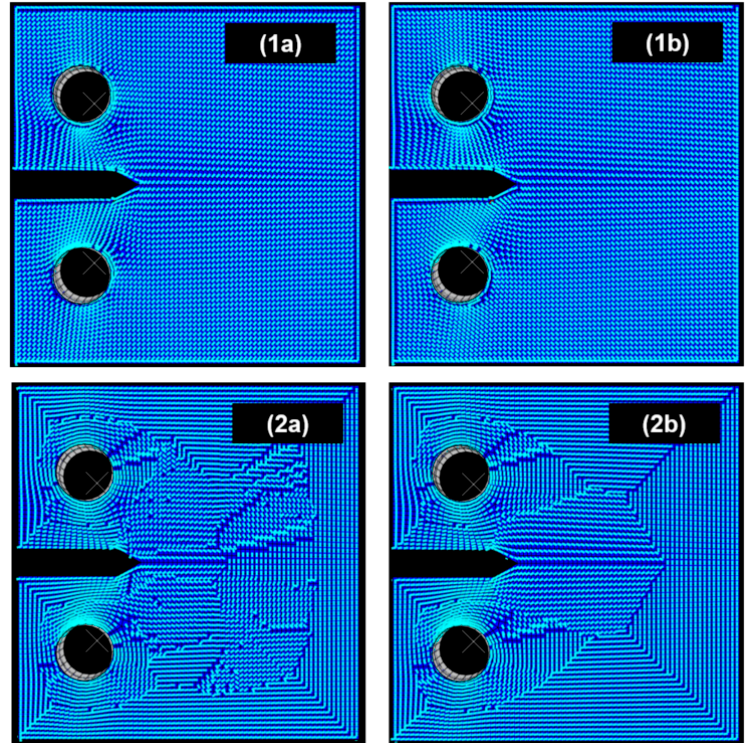
Figure 8 . Numerical models of the CT specimen. ( 1 ) Corresponds to the classical deposition with ±45° layers alternation. ( 2 ) For the optimized deposition; ( a ) denotes the first principal direction while ( b ) is for the second principal direction.